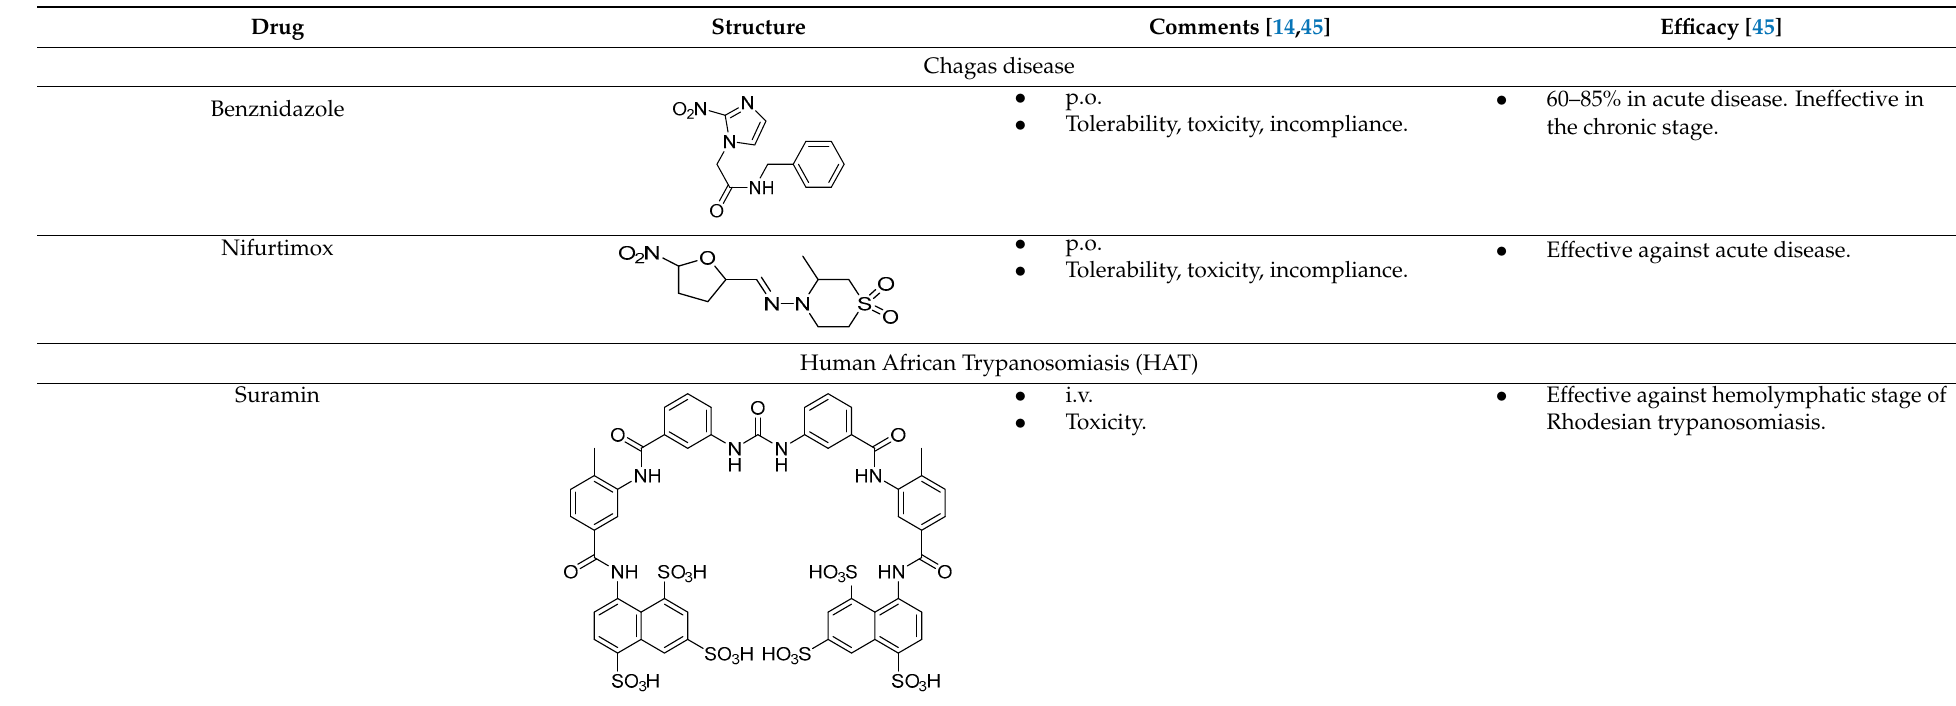
Table 1. Current drugs for kinetoplastid diseases.